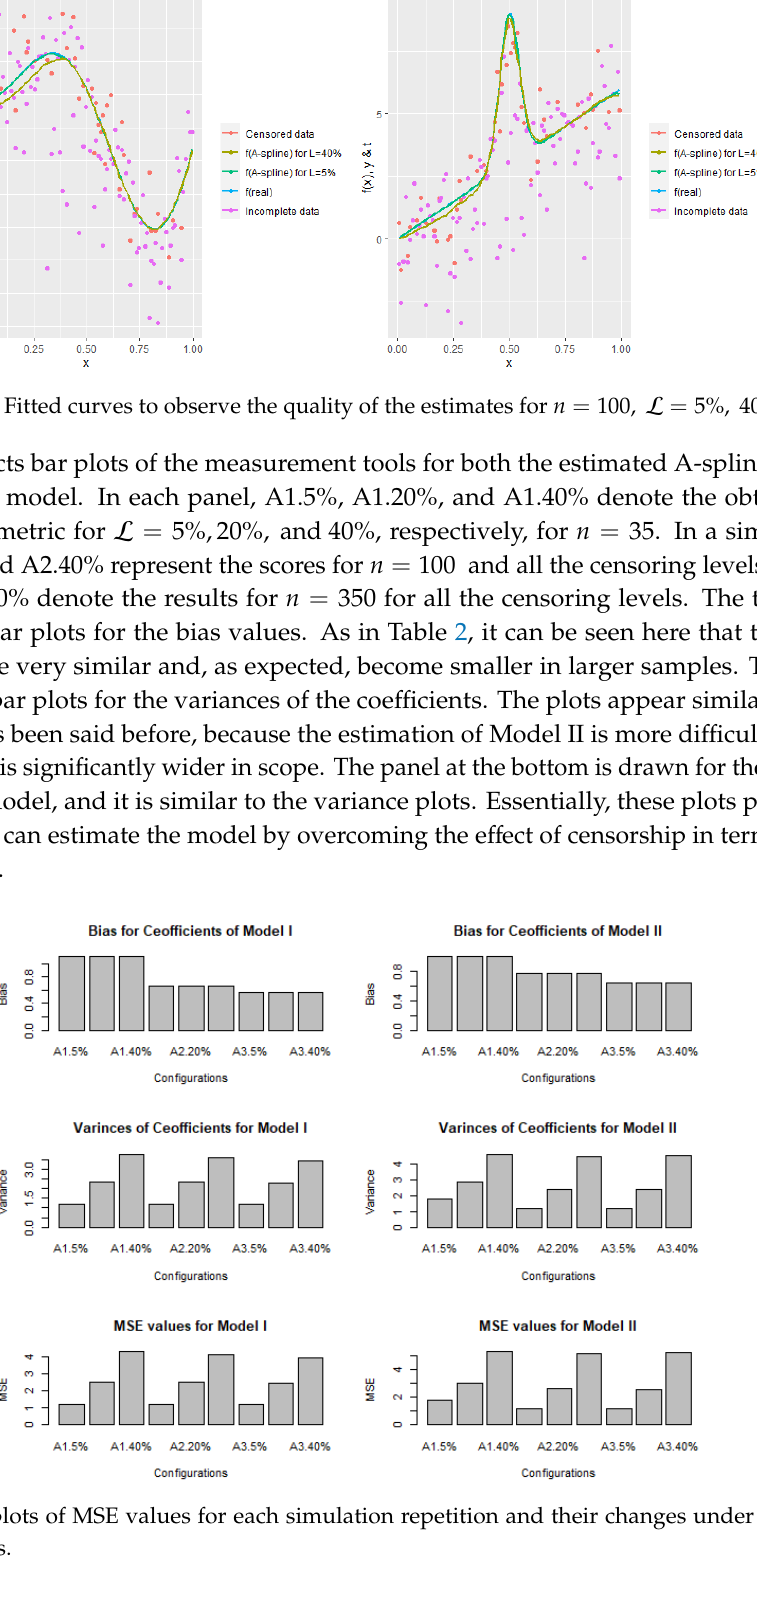
Figure 5. Bar plots of MSE values for each simulation repetition and their changes under di ff erent censoring